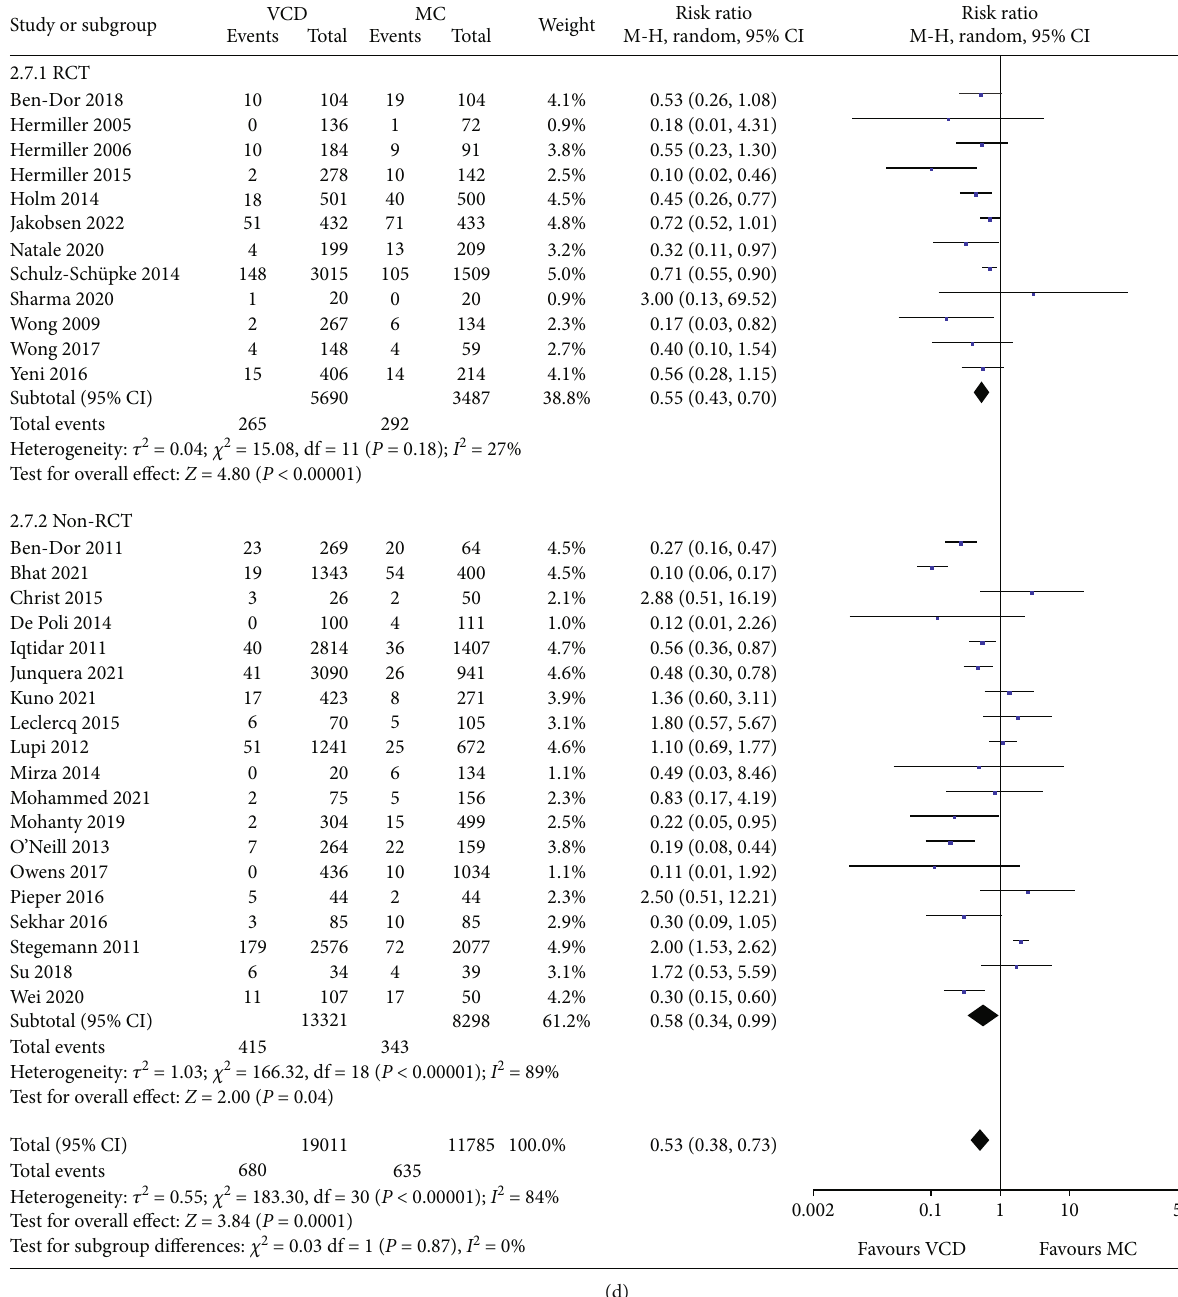
Figure 5: Forest plots comparing the (a) total vascular complications, (b) major vascular complications, (c) bleeding-related complications, and (d) bleeding-related complications omitting device failures between the VCD group and MC